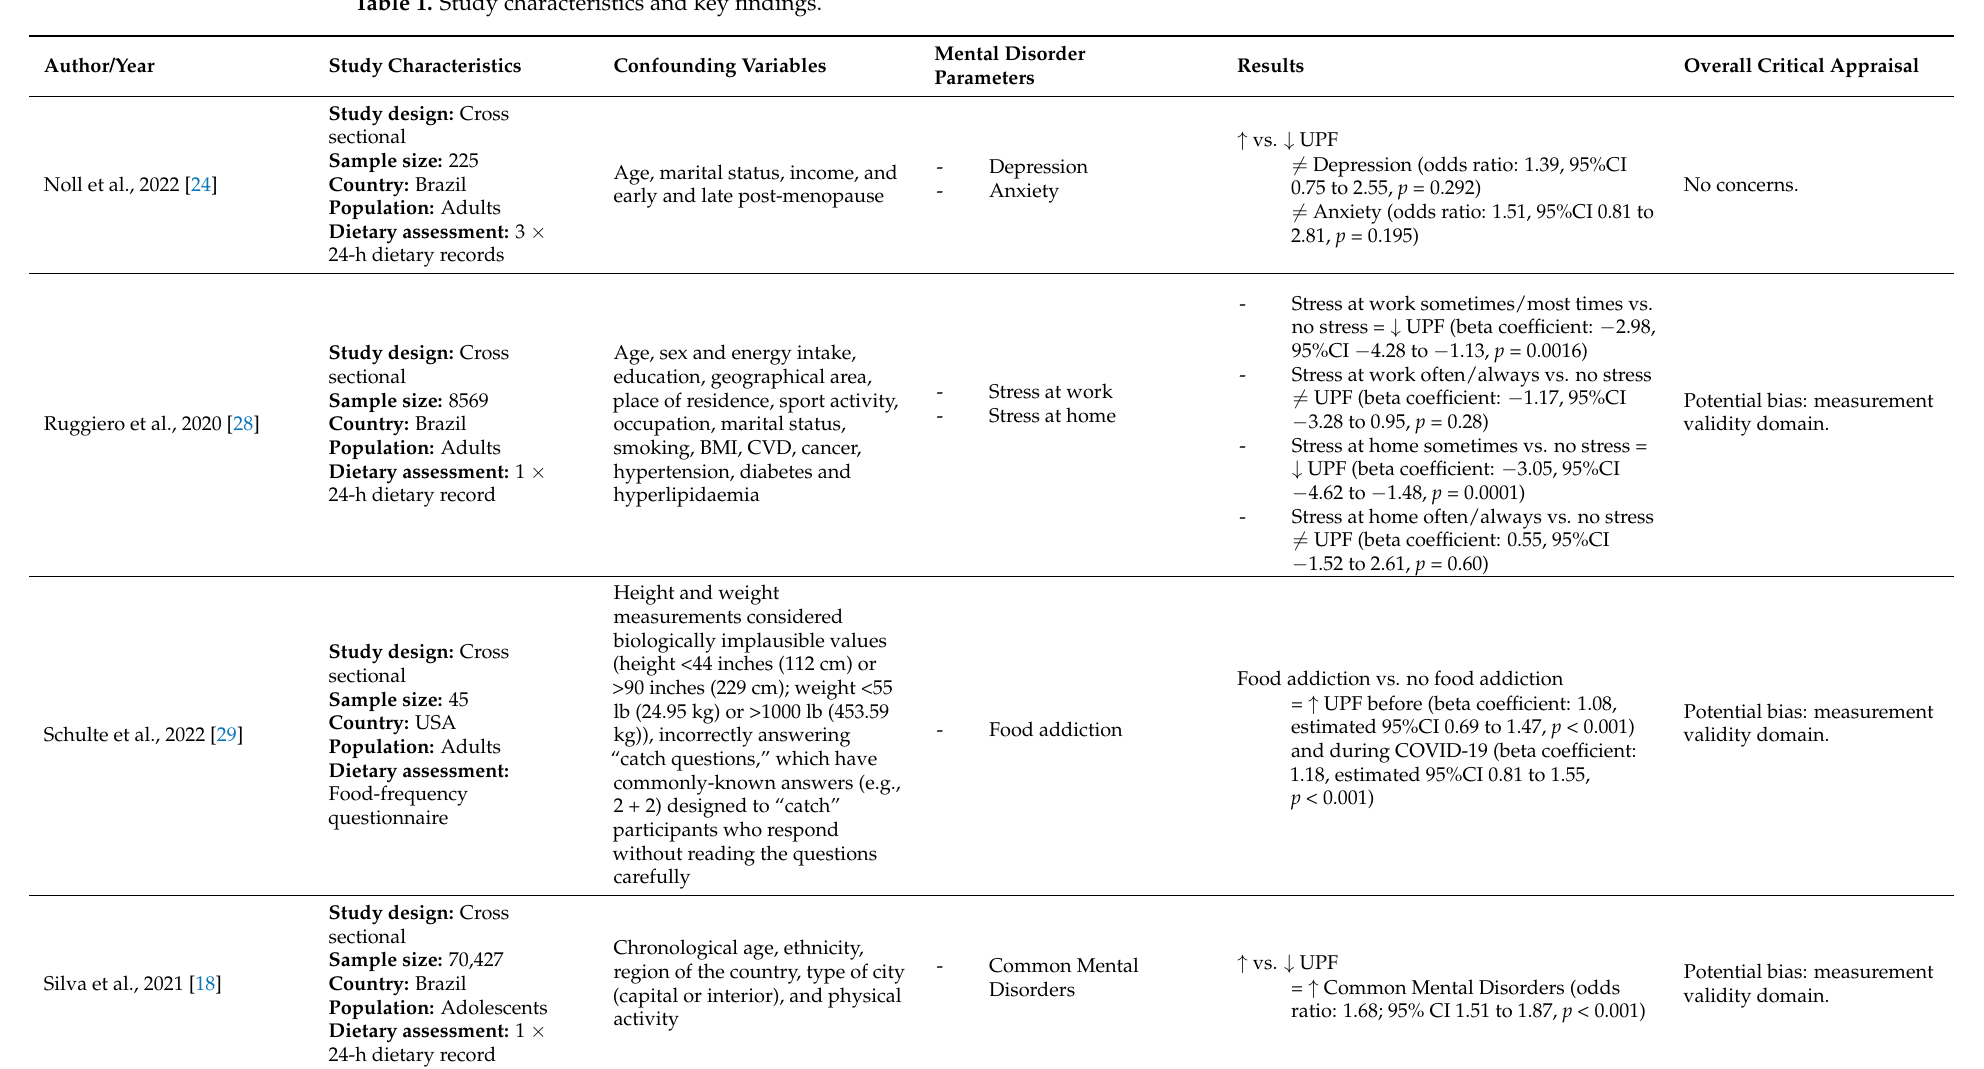
Table 1. Study characteristics and key